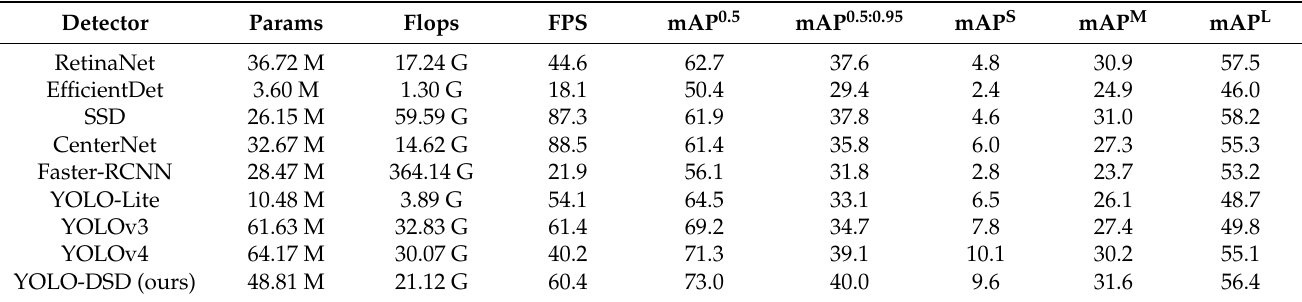
Table 9. Results of comparative experiment for different